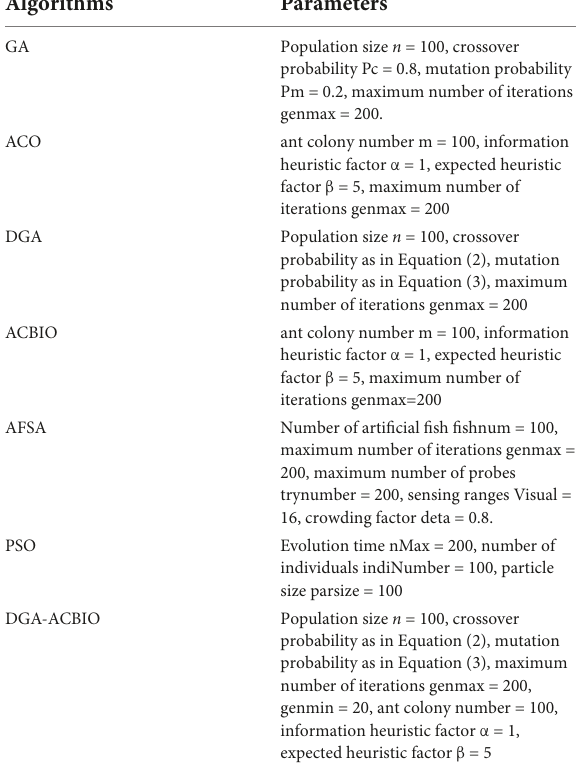
TABLE 1 Parameters for each